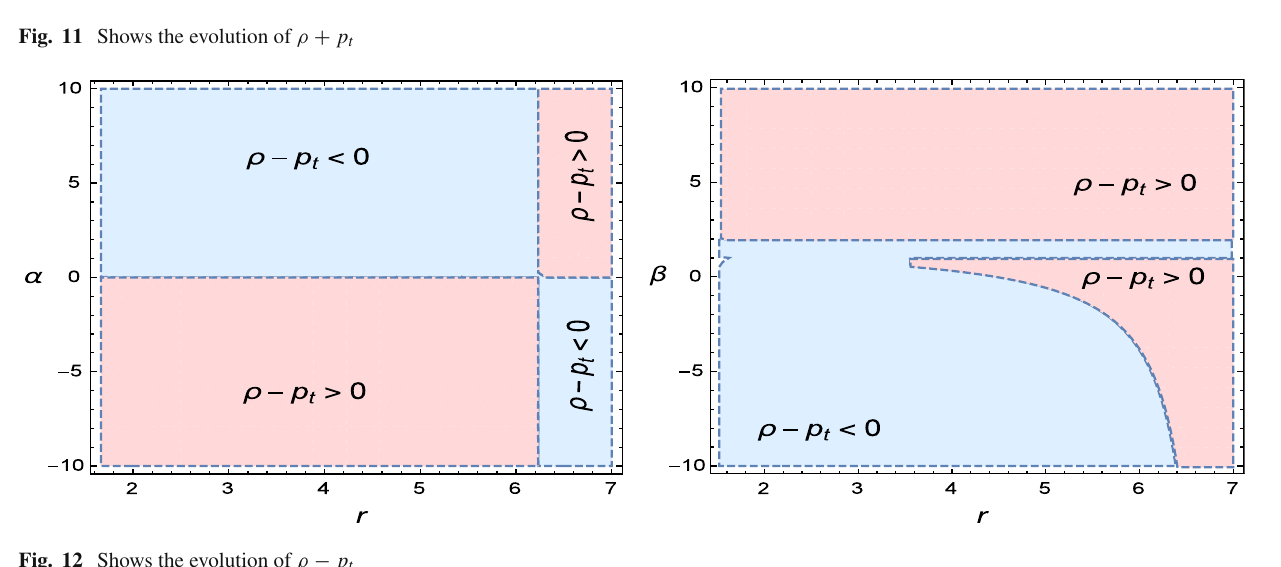
Fig. 12 Shows the evolution of ρ − p